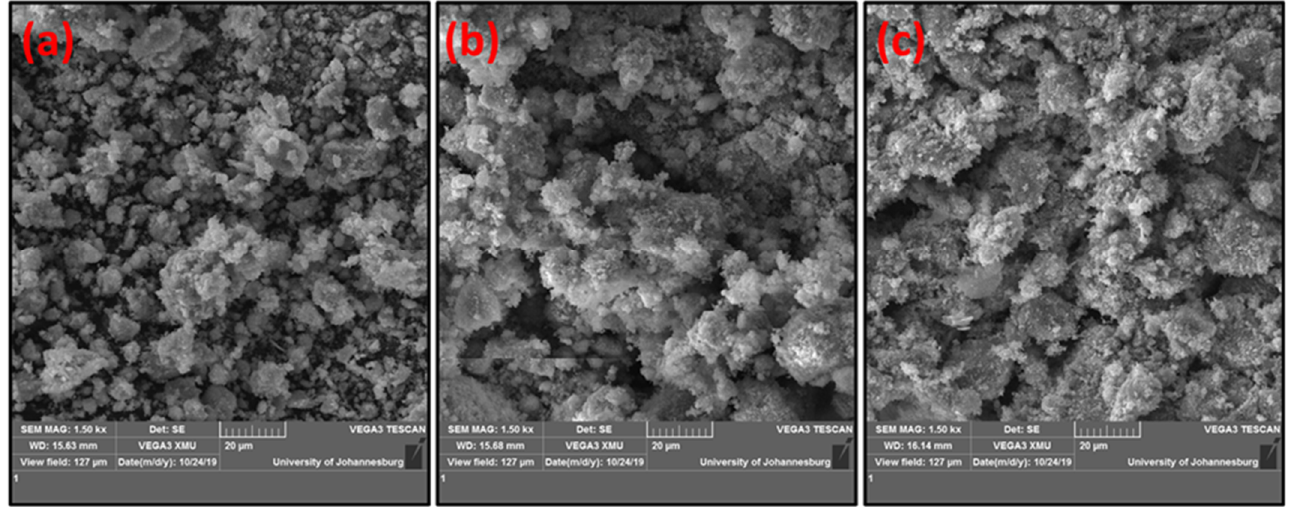
Figure 2. SEM images of prepared catalysts using different activation methods: ( a ) inactivated NiMo/AC 0 , ( b ) NiMo/AC X , ( c ) NiMo/AC T .